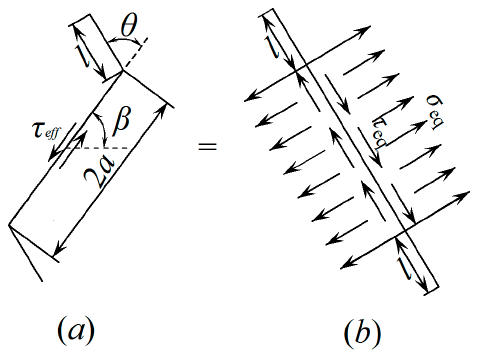
infl K I due to effec-